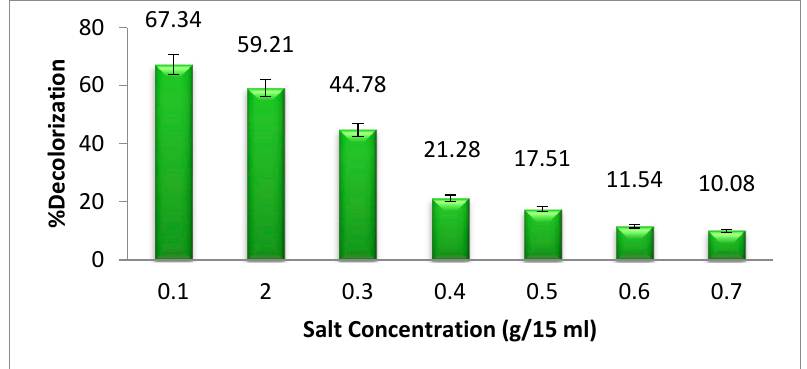
Figure 7. Effect of salt concentration on methyl orange degradation.